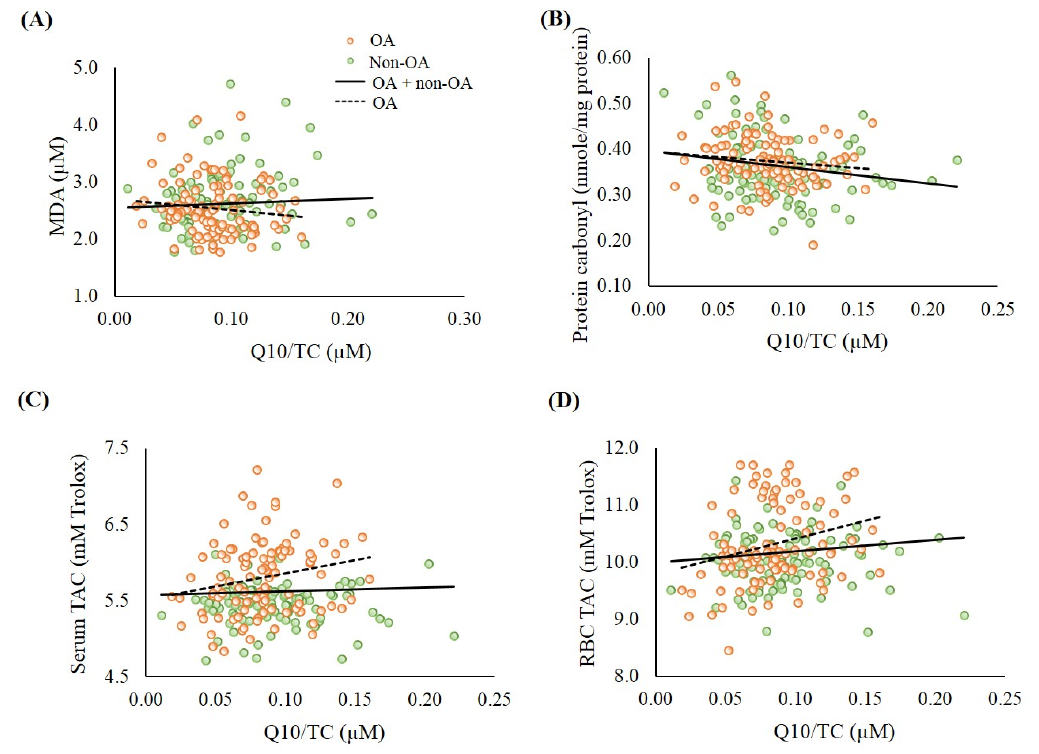
Figure 1. Correlations between coenzyme Q10 status and oxidative stress and total antioxidant